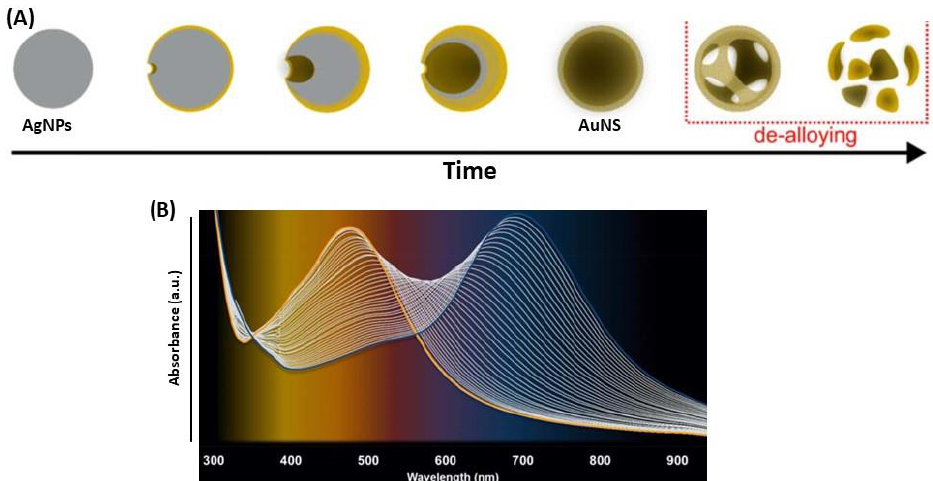
Figure 21. ( A ) The structural evolution of AuAg nanostructures during the galvanic replacement reaction upon addition of HAuCl 4 and ( B ) absorption spectra evolution as a function of time of AgNPs titrated with increasing volumes of HAuCl 4 to form AuNS: the LSPR band gradually shifts through the whole visible spectrum toward NIR wavelengths. Adapted from [175]. Copyright (2018), American Chemical Society.